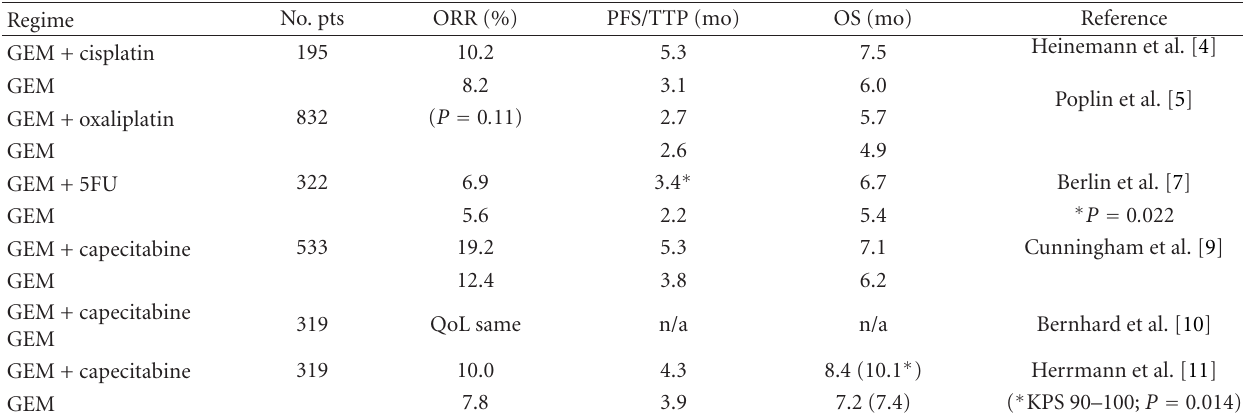
Table 1: Major phase III GEM-based combination chemotherapy.